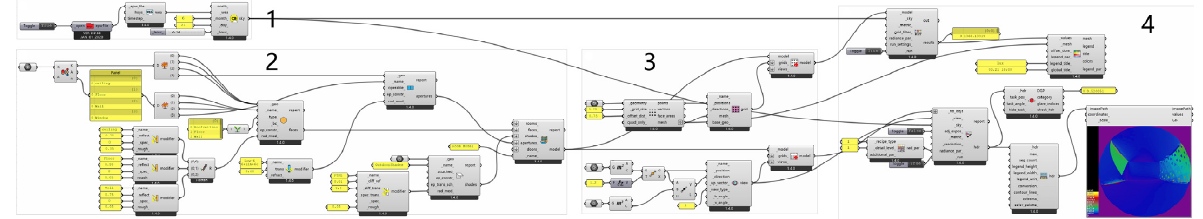
Figure 13. Environmental lighting performance simulation process (self-developed).